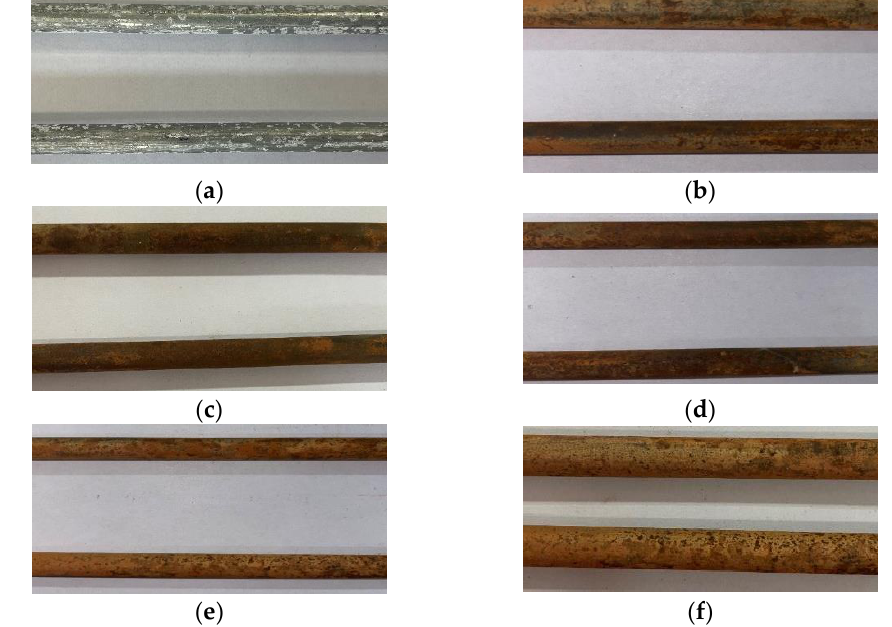
Figure 7. Samples of accelerated corrosion steel wire. ( a ) Matrix uncorroded specimens, ( b )